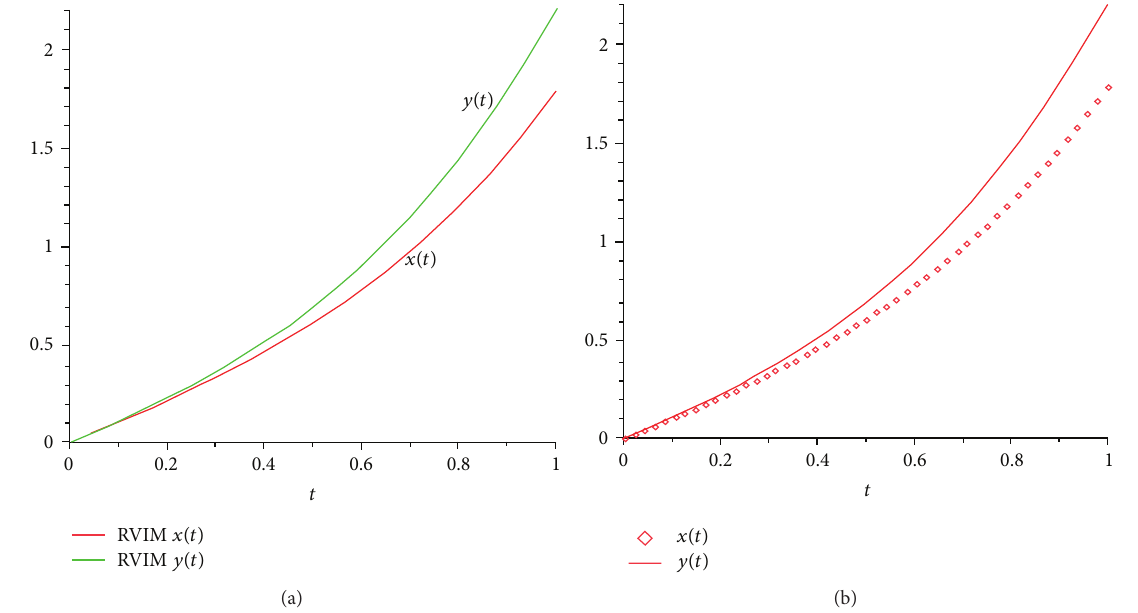
Figure 4: Plots of system (29): (a) RVIM method and (b) differential transform